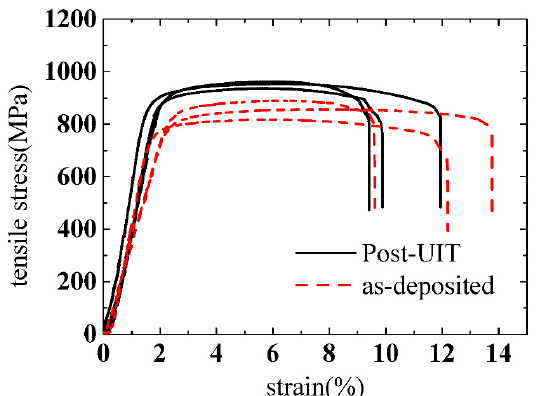
Figure 8. The tensile test result for both the post-UIT samples (black curves) and the as-deposited samples (red curves).